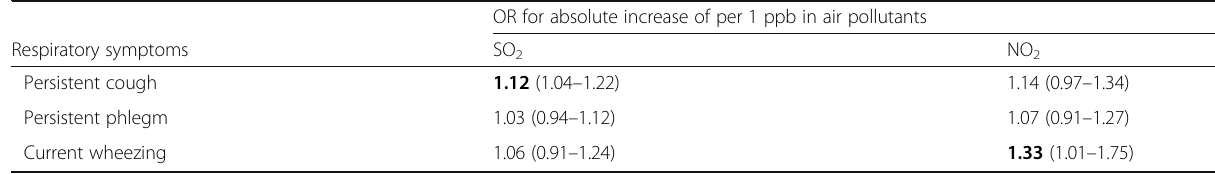
Table 4 The association between outdoor SO 2 and NO 2 concentrations and prevalence of respiratory symptoms among schoolchildren in the questionnaire survey using a logistic model, adjusted for confounding variables ( n = 1109) OR for absolute increase of per 1 ppb in air